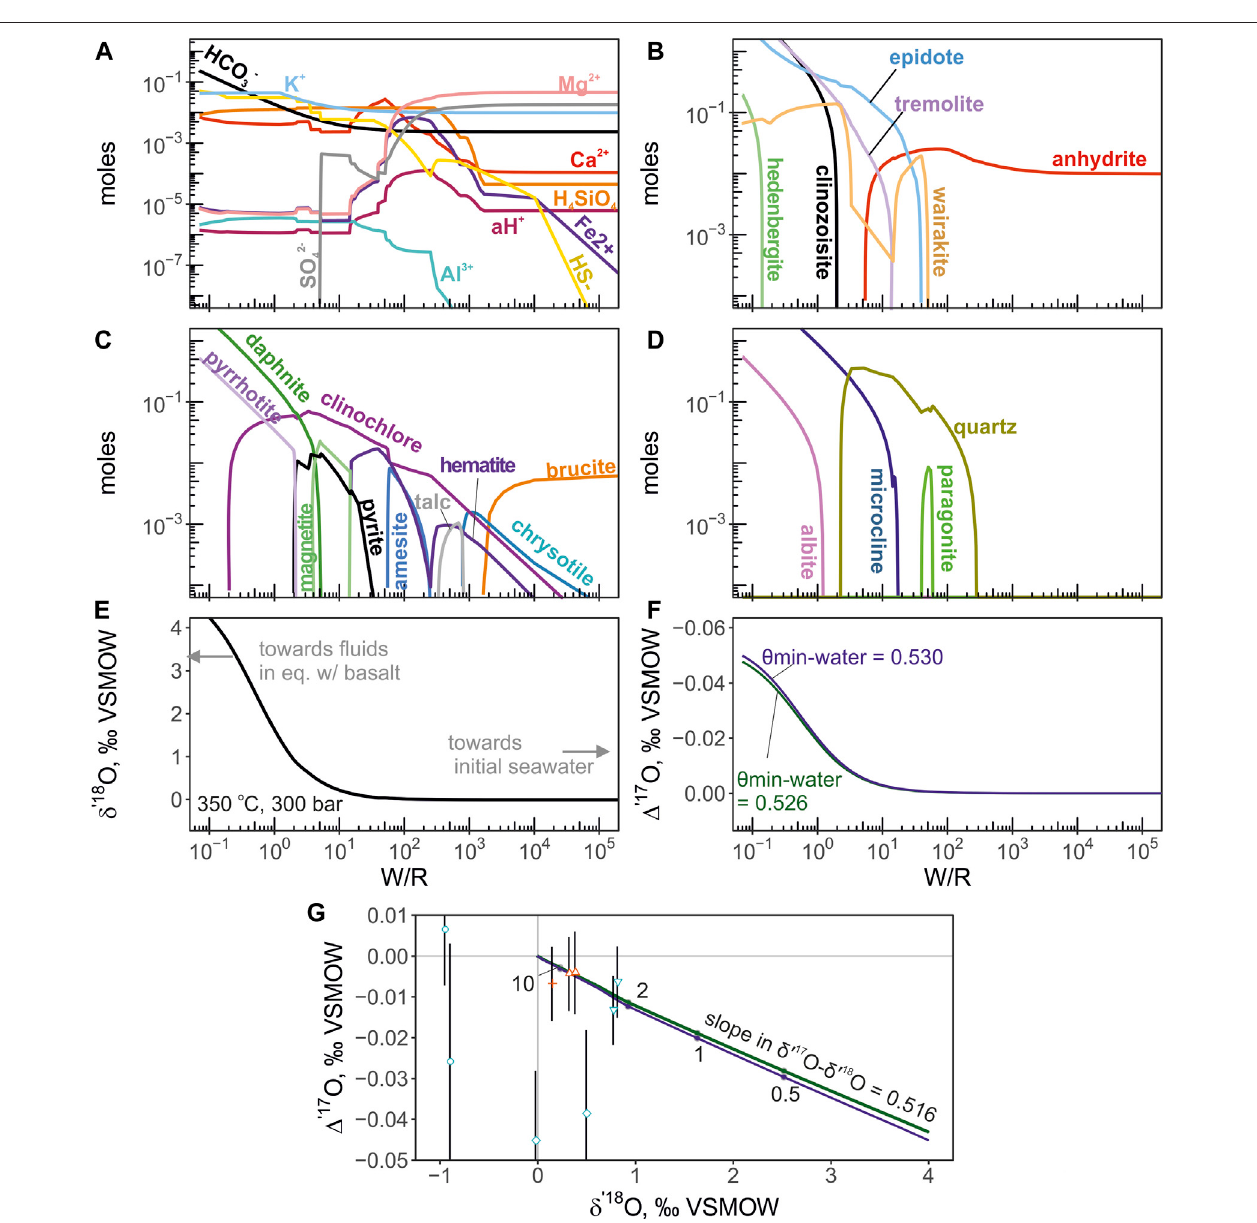
FIGURE 5 | The results of mineral-aqueous equilibrium calculation of seawater-basalt reaction at 350 ° C and 300 bars. The progress of basalt titration into 1 L (1020 g)ofseawaterisshownwithW/R.ThetripleoxygenisotopevaluesoftheequilibriumH 2 Oarecalculatedfromthemassbalanceofthereactionandtheequilibrium mineral-waterfractionationfactors(seeMethods). (A) — totalmolalitiesofaqueousspecies. (B) — molarabundancesofCa-bearingminerals. (C) — abundancesofFe-Mg silicates, oxides and sul fi des. (D) — abundances of Al-silicates and quartz. (E, F) — the calculated triple oxygen isotope shifts experienced by the fl uid. The Δ ′ 17 O is calculated using θ values of 0.526 (green line) and 0.530 (blue). Panel (G) shows the calculated trajectory of fl uid evolution and the compositions of endmember values from the vents studied here in δ ′ 18 O — Δ ′ 17 O coordinates. The effect of different θ values is shown with respective colors. The slope of the trajectory is 0.516 in δ ′ 17 O — δ ′ 18 O coordinates. The W/R ratios are labeled with digits. Different vent fl uid localities are denoted by symbols in the same manner as in the Figure 5 .